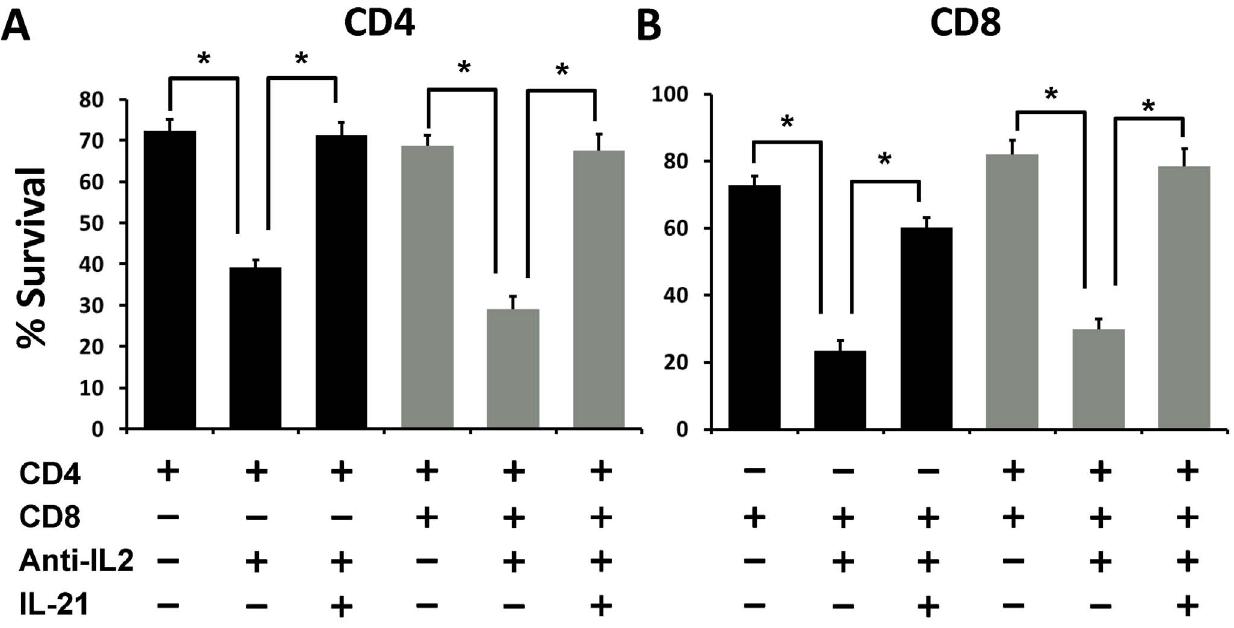
Figure 6. IL-21 is critical for maintaining survival of CD4 and CD8 T cells under IL-2 inhibition. CD4 + CD25 2 and CD8 + CD25 2 T cells were isolated from IL-21 KO mice, and were cultured together (2.5 6 10 4 cells/well from each population) or individually (5 6 10 4 /well) as indicated in a 96- well plate. The cells were stimulated with anti-CD3/CD28 mAb’s in presence or absence of anti-IL-2 and recombinant murine IL-21 as indicated. The cells were harvested at 48 hrs post-culture and subsequently stained for CD4, CD8 and PI for measuring cell survival. ( A ) The bar graph shows frequency of PI negative cells within CD4 + T cell population when cultured alone ( black bars ) or with CD8 + T cells ( gray bars ). ( B ) Bars graph shows frequency of PI negative cells within CD8 + T cell population when cultured alone ( black bars ) or with CD4 + T cells ( gray bars ). The figure shows results from one representative experiment which was repeated three times with similar results. Bars indicate average value 6 SD obtained from three culture wells (technical triplicates) in each experimental group (*denotes p ,